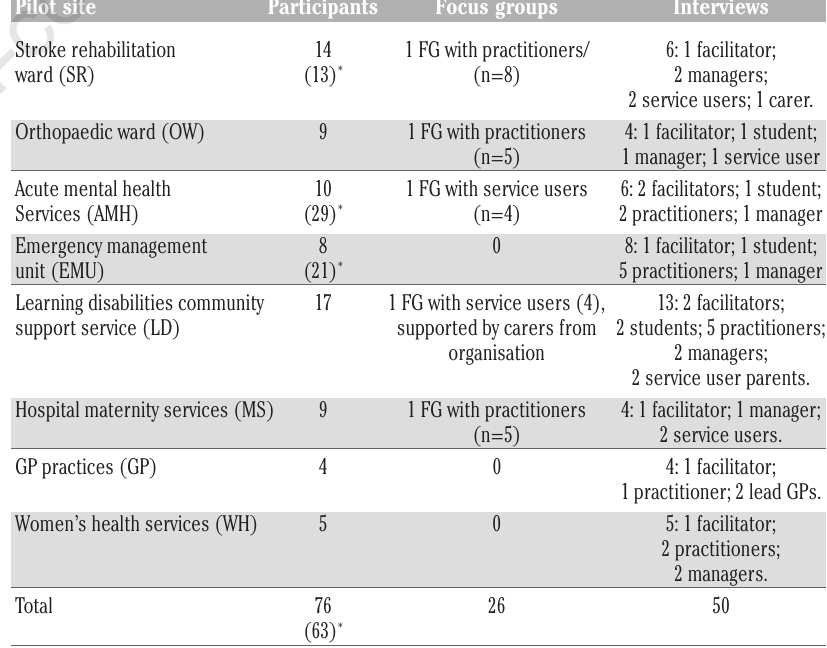
Table 1. Participation in focus groups and interviews by pilot